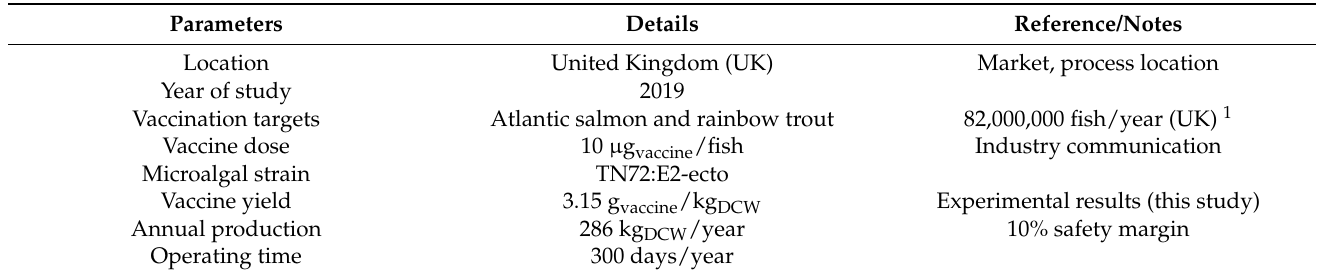
Table 1. Details of the case study on the industrial production of a microalgae-based edible vaccine against SAV for aquaculture applications.